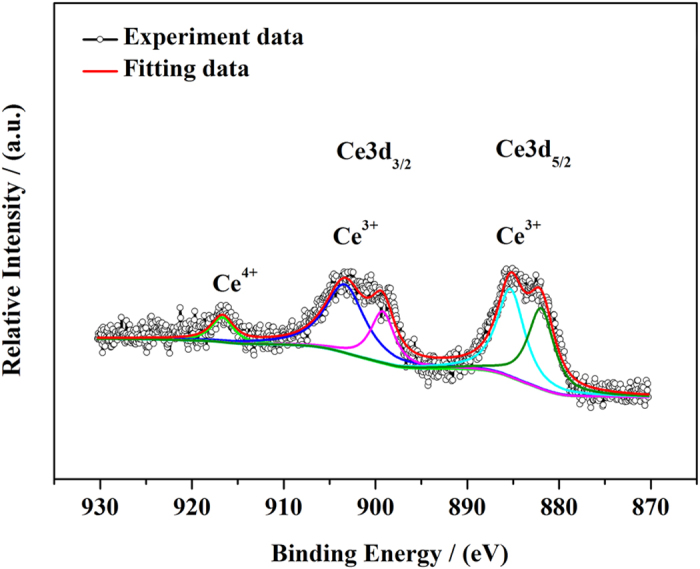
The XPS spectrum of Ce3d electrons in YAG:Ce sample-1 (1030 °C for 3 h).